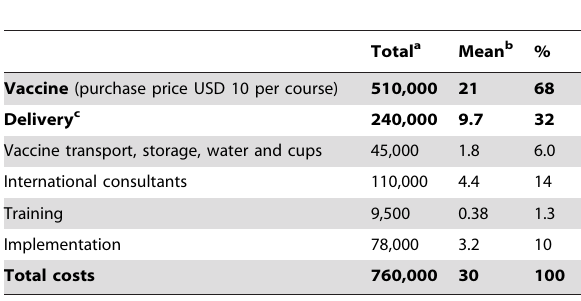
Table 5. Costs of a mass oral cholera vaccination campaign, Zanzibar,